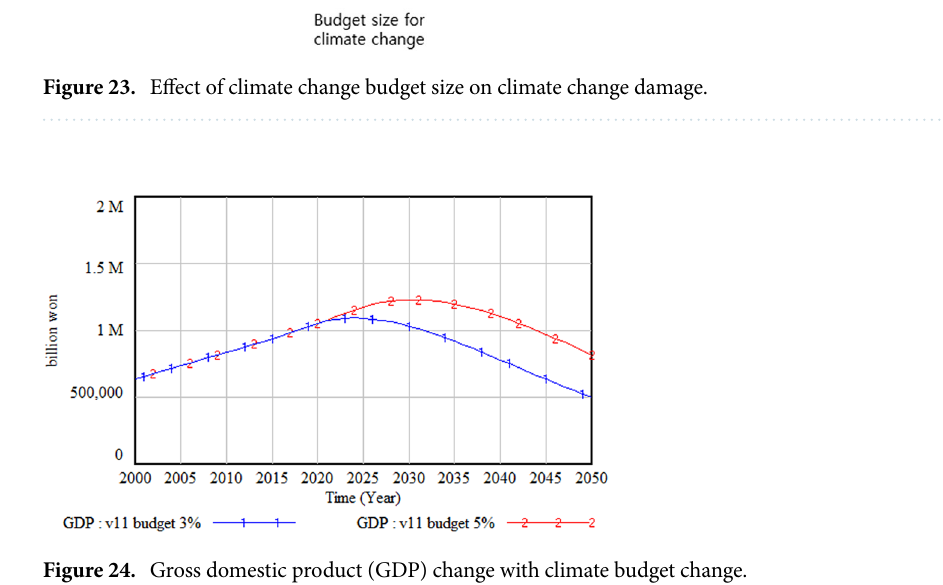
Figure 24. Gross domestic product (GDP) change with climate budget